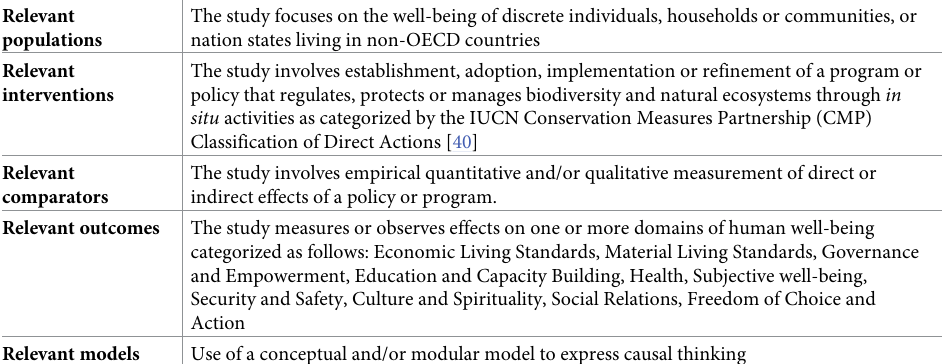
Table 1. Scope covered in the conservation literature dataset used in this analysis (derived from McKinnon et al. 2016). Relevant